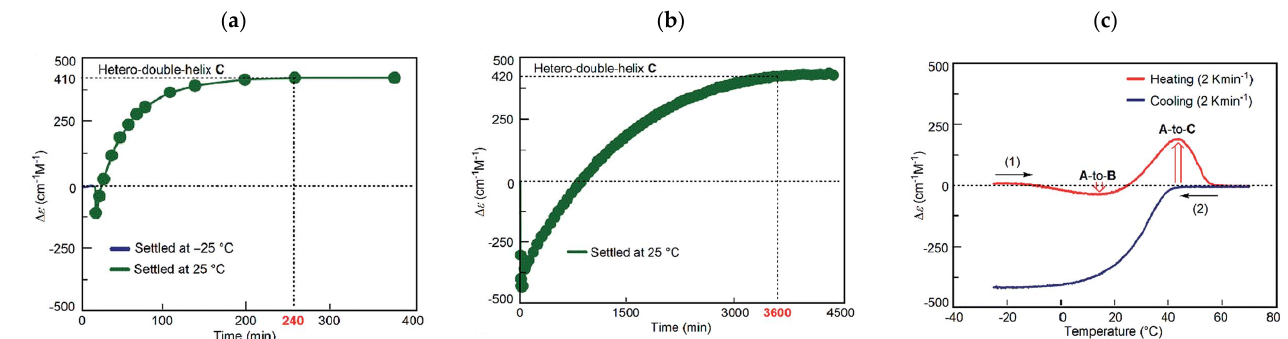
Figure 19. Chemical kinetics of ( P )- 7 and ( M )- 8 at 25 ◦ C in fluorobenzene (0.5 mM) during ( a ) rapid cooling to − 25 ◦ C and rapid heating to 25 ◦ C and ( b ) rapid cooling from 70 to 25 ◦ C. ( c ) Heating and cooling experiment at a rate of 2 K min − 1 between − 25 ◦ C and 70 ◦ C. Reproduced from ref. [66]. The significant effect of the cooling history is ascribed to difference in temperature dependency among the competitive self-catalytic chemical reactions 2 A (A) + C (A) → 2 C (A) and 2 A (A) + B (A) → 2 B (A) (Figure 19c). The heating of 2 A (A) from − 25 ◦ C at a rate of 2